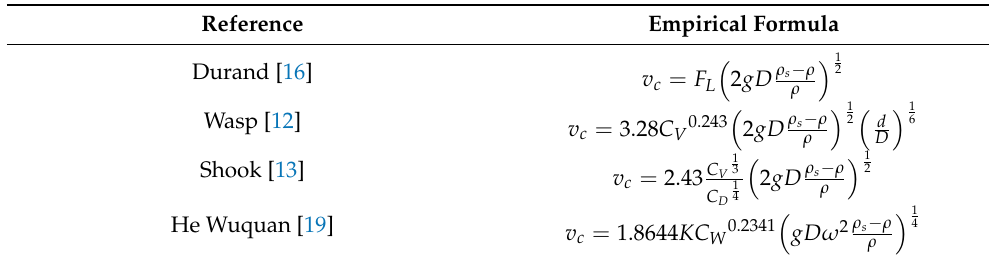
Table 3. Empirical formula of critical velocity for horizontal